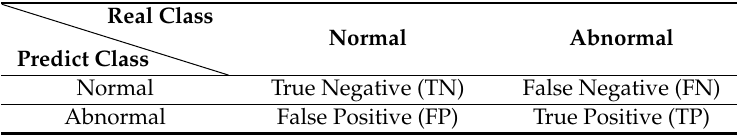
Table 1. The meaning of TP, TN, FP,